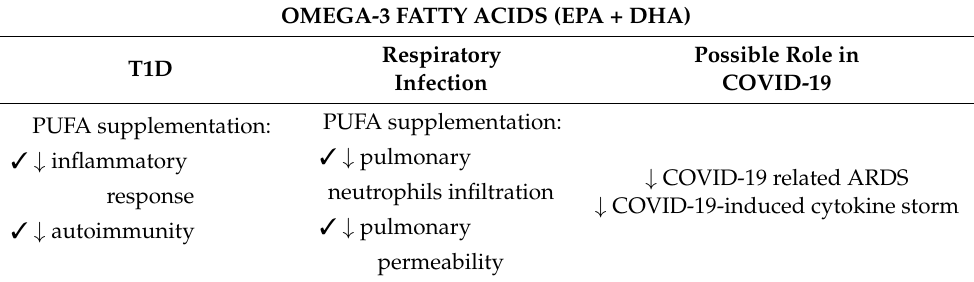
Table 2. Evidences related to PUFA supplementation in T1D, respiratory infection and its possible association with